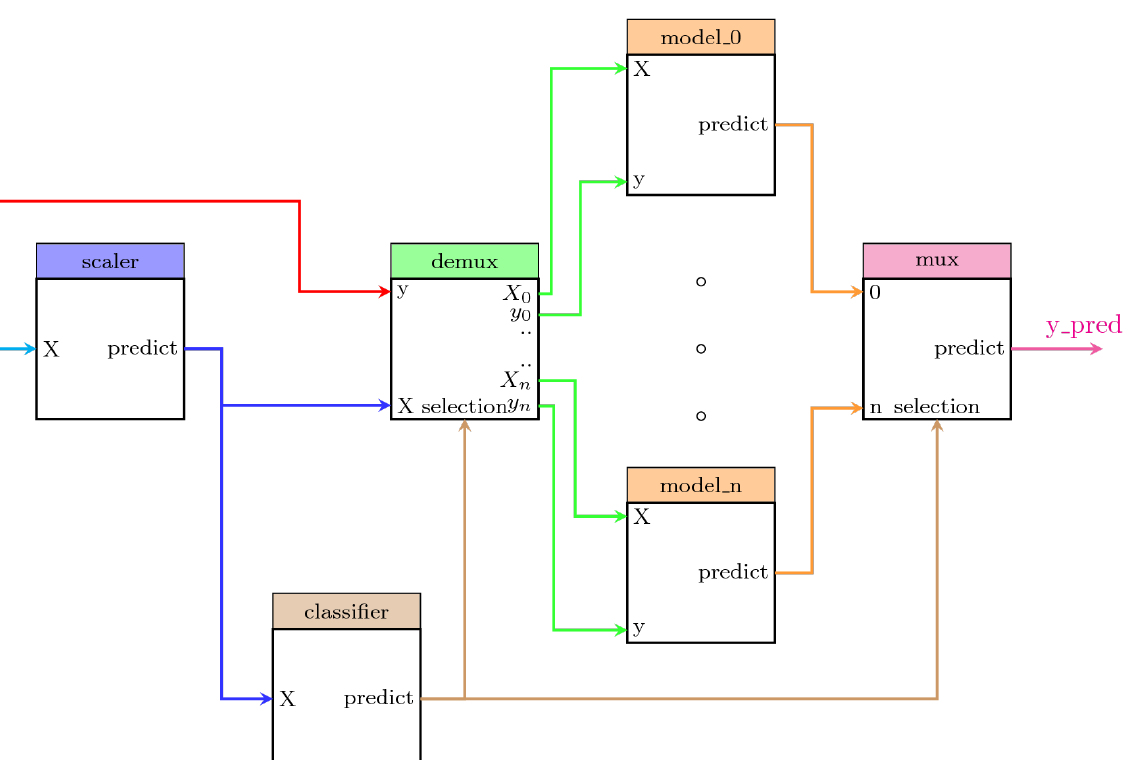
Figure 5. Parallel workflow with automatic wiring of the prediction models according to the labels contained in a